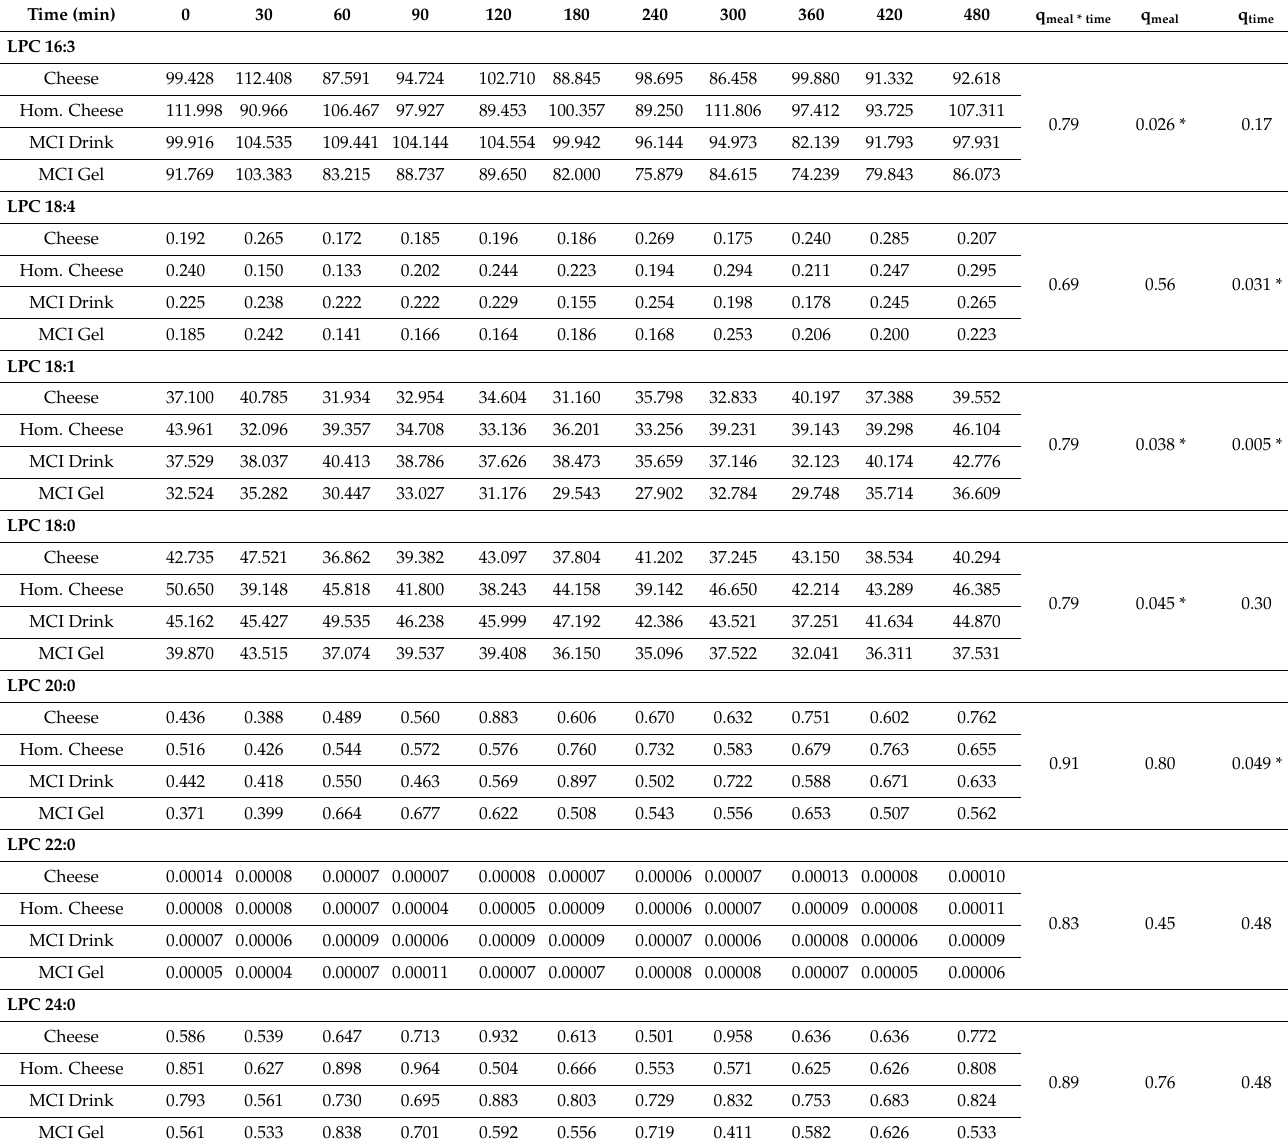
Table 2. Relative level of lysophosphatidylcholine (LPC) in plasma samples.* Data were analyzed by repeated measures using a linear mixed model. Overall participant and within-visit participant differences were included as random factors and the analyses were adjusted for BMI, age and visit. q -values indicate FDR-adjusted p -values for meal–time interactions (q meal * time ), the effect of meal (q meal ) and the effect of time (q time ). * indicate significant differences ( q <